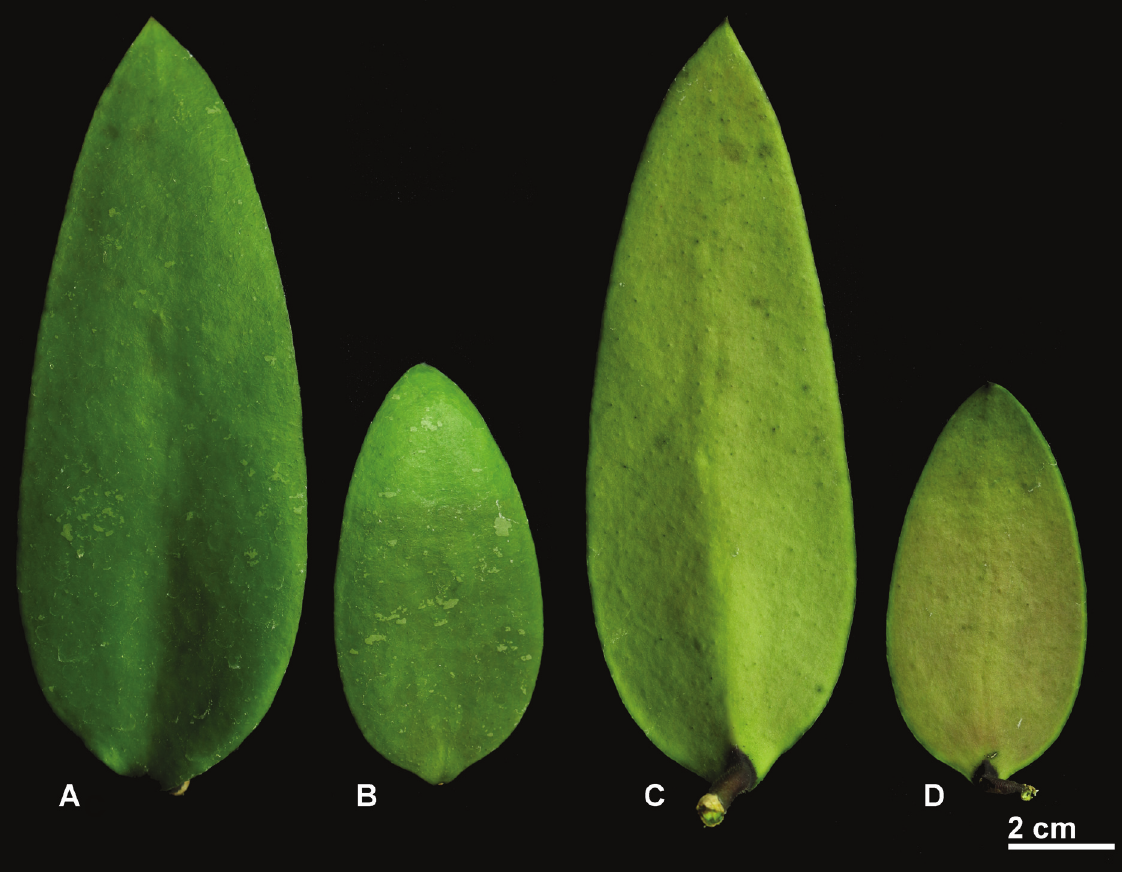
Fig. 4. Hoya sumatrana S.Rahayu & Rodda sp. nov. A – B . Leaves from above. C – D . Leaves from from underneath. Photos: M.